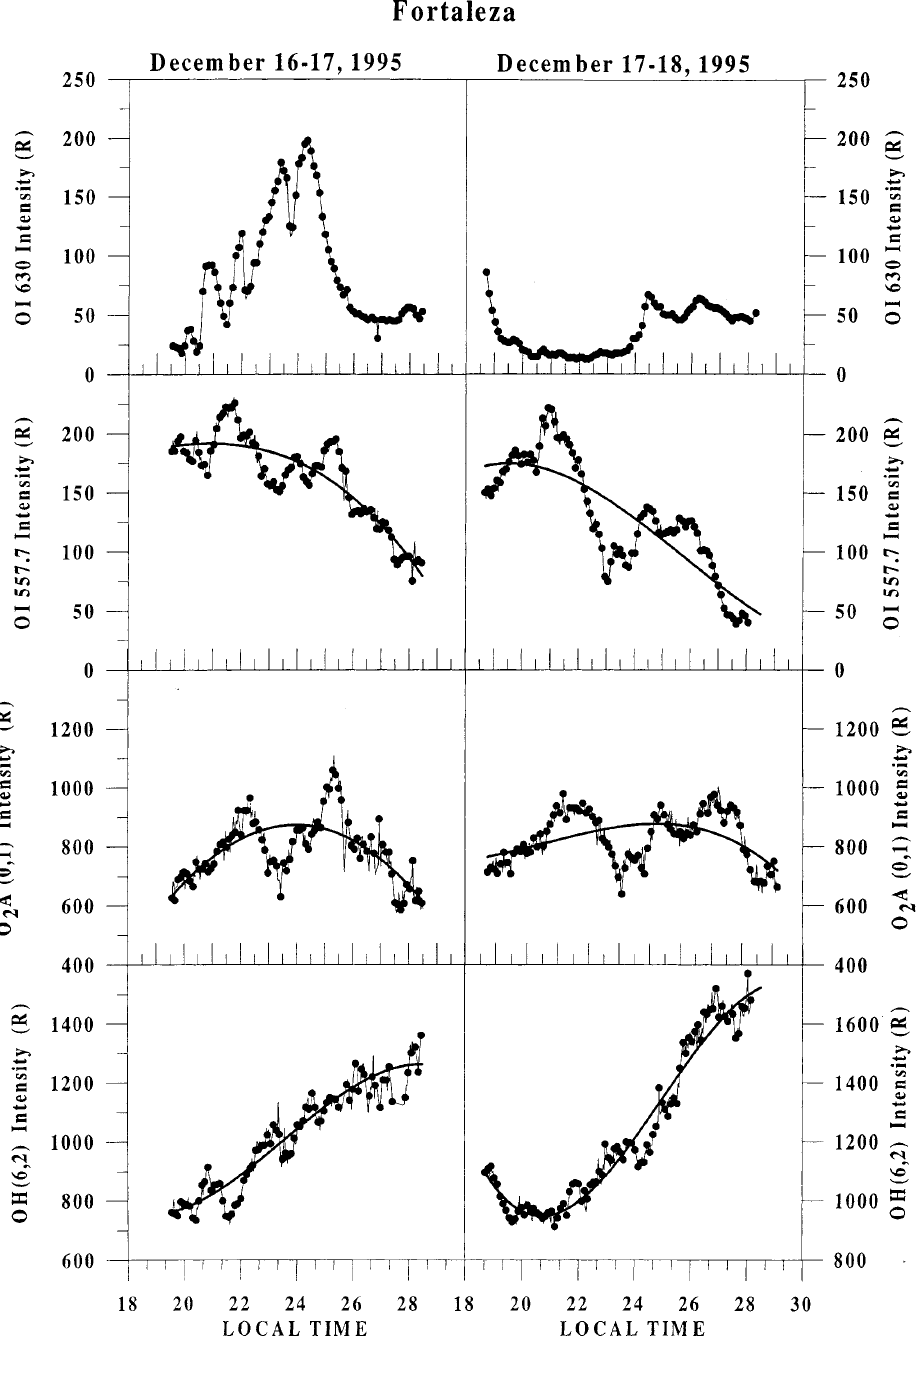
Fig. 7. Nocturnal intensity vari- ations of the OI 630 nm emission observed on December 16–17, 1995 and December 17–18, 1995, at Fortaleza (3.9 (cid:176) S, 38.4 (cid:176) W), along with other mesospheric emissions ( continuous line shows the night-time variation, exclud- ing the short period fluctuations; Fagundes et al